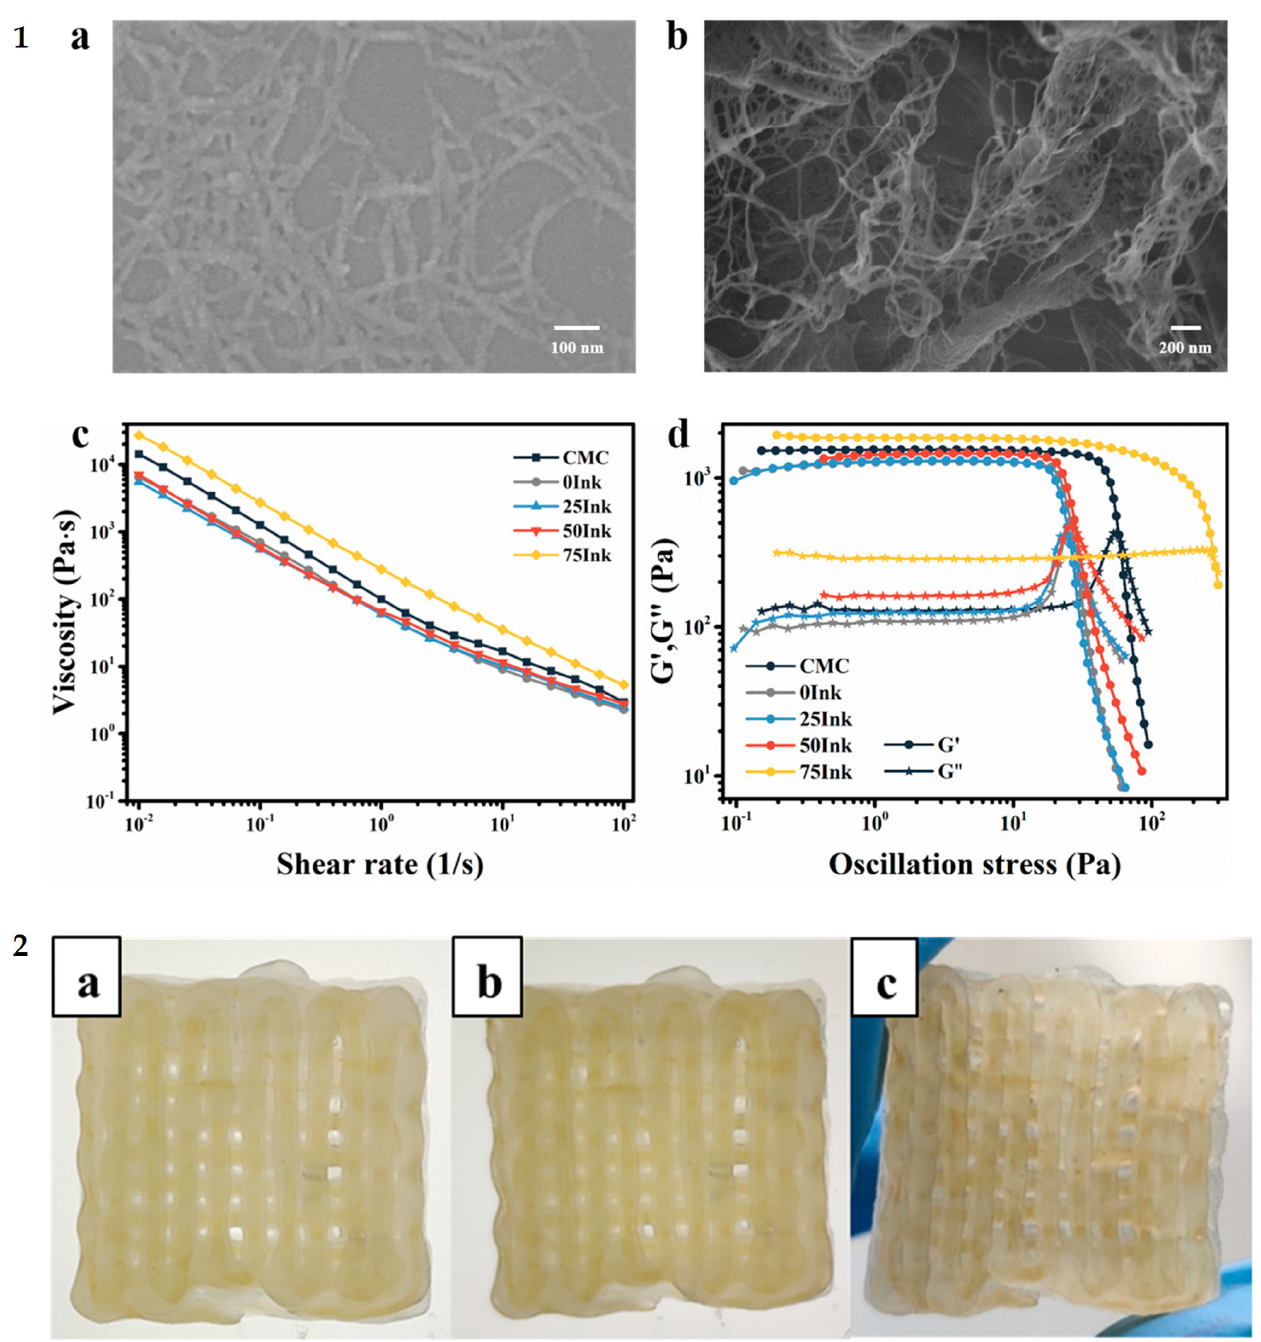
Figure 11. SEM images of CMC before ( 1a ) and after freeze-drying ( 1b ). Viscosity as a function of the shear rate for CMC and CMC-based inks ( 1c ), G ′ and G ″ as a function of the shear stress for CMC and CMC-based inks ( 1d ); Photographs of CMC-based 3D-printed aerogel before curing ( 2a ), after curing ( 2b ) and after freeze-drying ( 2c ), used with permission from Ref. [50].